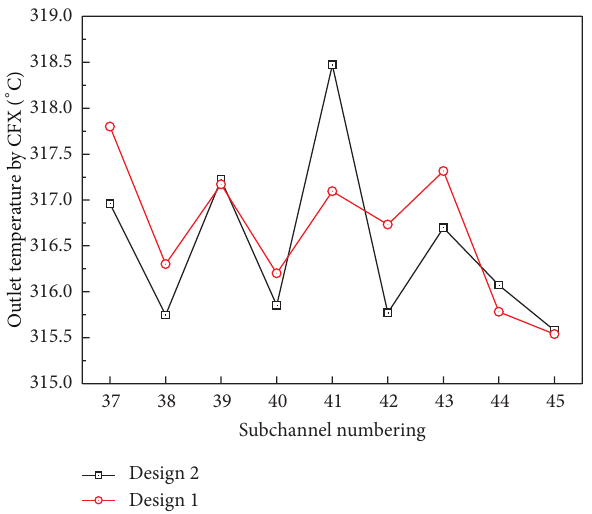
Figure 11: Side subchannel outlet temperature calculated in CFX for Design 1 &